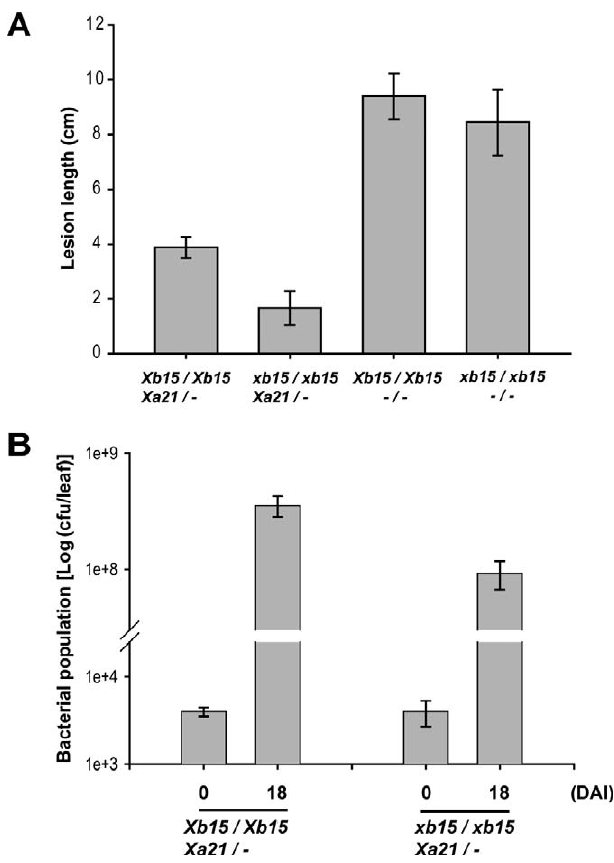
Figure 6. XA21 Rice Plants Carrying Xb15 Tos17 Gene Exhibit Increased Resistance of Xoo (A) Three-week-old segregants (F 4 ) of NF9014–1 ( Tos17 Xb15 ) and Myc- XA21 were inoculated with Xoo PR6 and lesion lengths were measured 18 DAI. Each data point represents the average and standard deviation of at least three samples. (B) Bacterial populations were determined at 0 and 18 DAI. For each time point, the mean of the bacterial cfu/leaf from three plants per genotype is shown. Error bars indicate the standard deviation. The experiment was repeated three times with similar